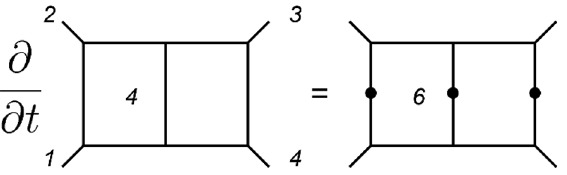
Figure 4 . Relation between two loop four point d = 4 and d = 6 double box dual conformal integrals (their I functions). Numbers in the diagram indicate dimensionality of the corresponding